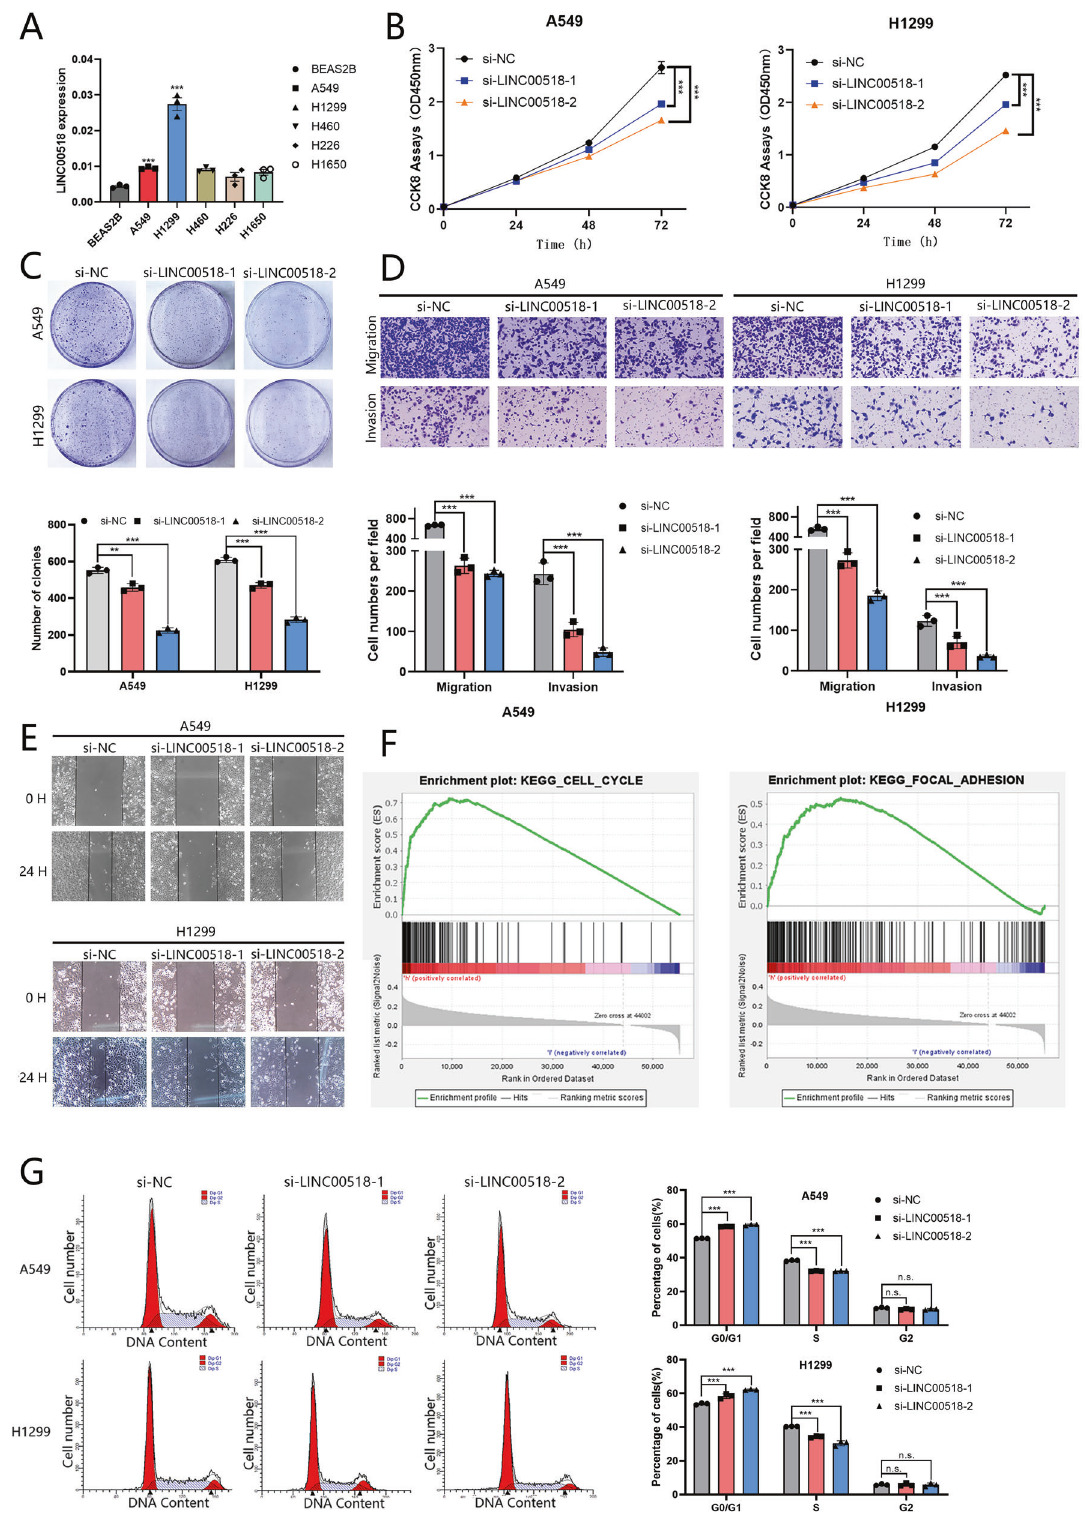
Fig. 2 Knockdown of LINC00518 suppressed cell proliferation and metastasis, and reduced viability. A Expression level of LINC00518 in human bronchial epithelial cells (BEAS-2B) and lung cancer cell lines(A549, H1299, H460, H226, H1650) detected by qRT – PCR. B , C Cell proliferation was detected by CCK-8 assay and Colony formation analysis. D , E The cell metastasis capability was tested by Transwell assay and Wound-healing assay. F Kegg pathway analysis identi fi ed that LINC00518 in fl uenced the cell cycle and focal adhesion. G Cell cycle distributions were analyzed in A549/H1299 cells. All results indicate SD. (* P < 0.05, ** P < 0.01, *** P < 0.001).